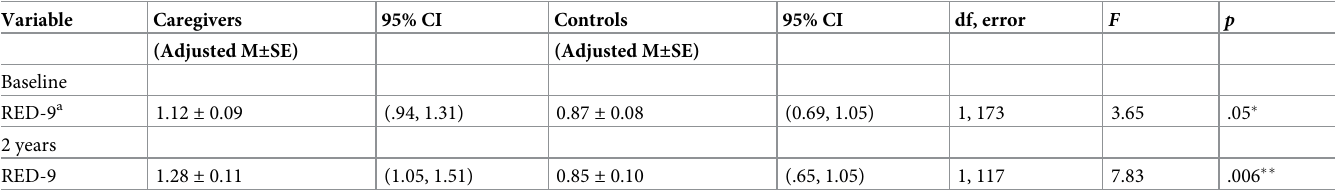
Table 7. Group differences in reward-driven eating behavior at baseline, adjusting for baseline BMI (top panel); and 2 years, adjusting for 2 year BMI (bottom